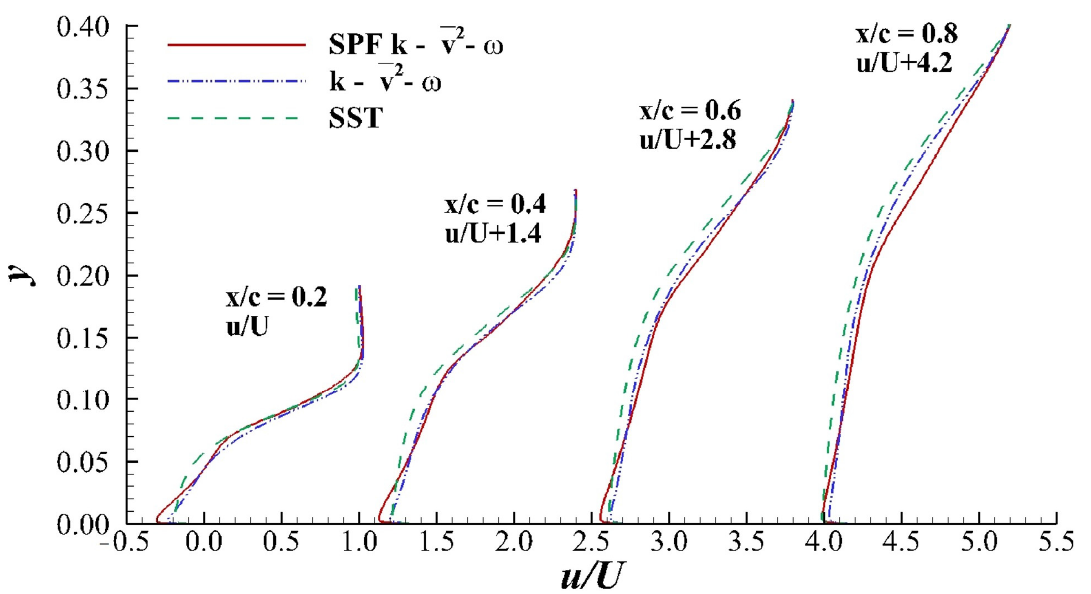
Figure 5. Velocity profiles given by SST, k − v 2 − ω and SPF models on the upper surface of the airfoil = 0.2, x = 0.4, x = 0.6 and x = 0.8. AOA = 17 ◦ , Re = 3 × 10 5 and Ma = 0.12. The profiles are at x c c c c shifted for